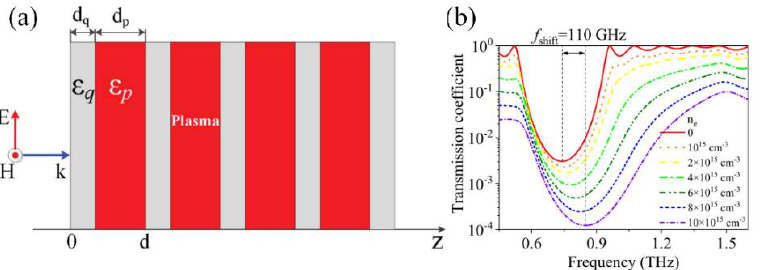
Figure 6. ( a ) Schematic diagram of one-dimensional collision microplasma photonic crystal; ( b ) relationship between the transmission coefficient of the first terahertz band gap and the frequency of the incident wave under different electron densities [53].